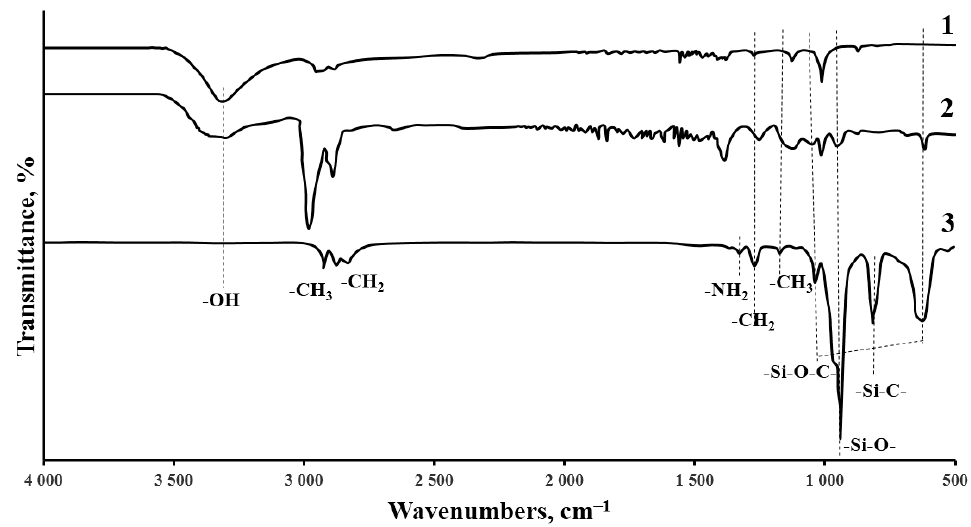
Figure 3. FT-IR spectroscopy of samples: 1—initial GO; 2—GO, after APTES treatment; 3—APTES.